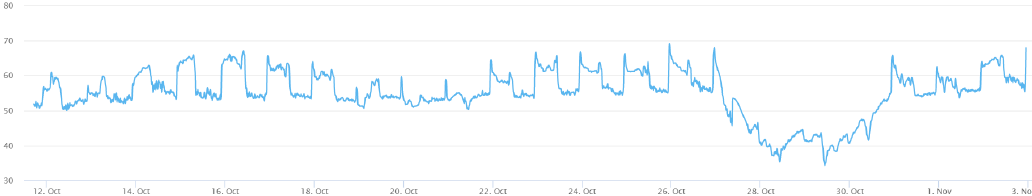
Figure 23. The humidity observations from the device 24 between 2018/10/12 to 2018/11/02.